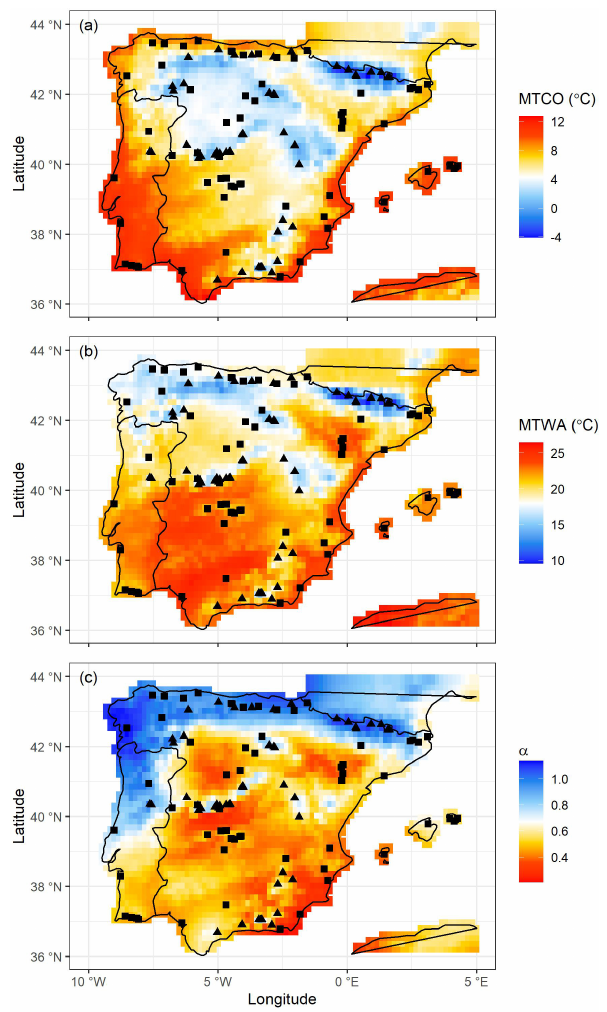
Figure 2. Map showing the location of the 117 fossil sites in the Iberian Peninsula used for climate reconstructions. Sites lower than 1000ma . s . l . are shown as squares and sites higher than 1000ma . s . l . are shown as triangles. The base maps show modern (a) mean tem- perature of the coldest month (MTCO), (b) mean temperature of the warmest month (MTWA) and (c) plant-available moisture as repre- sented by α , an estimate of the ratio of actual evapotranspiration to equilibrium